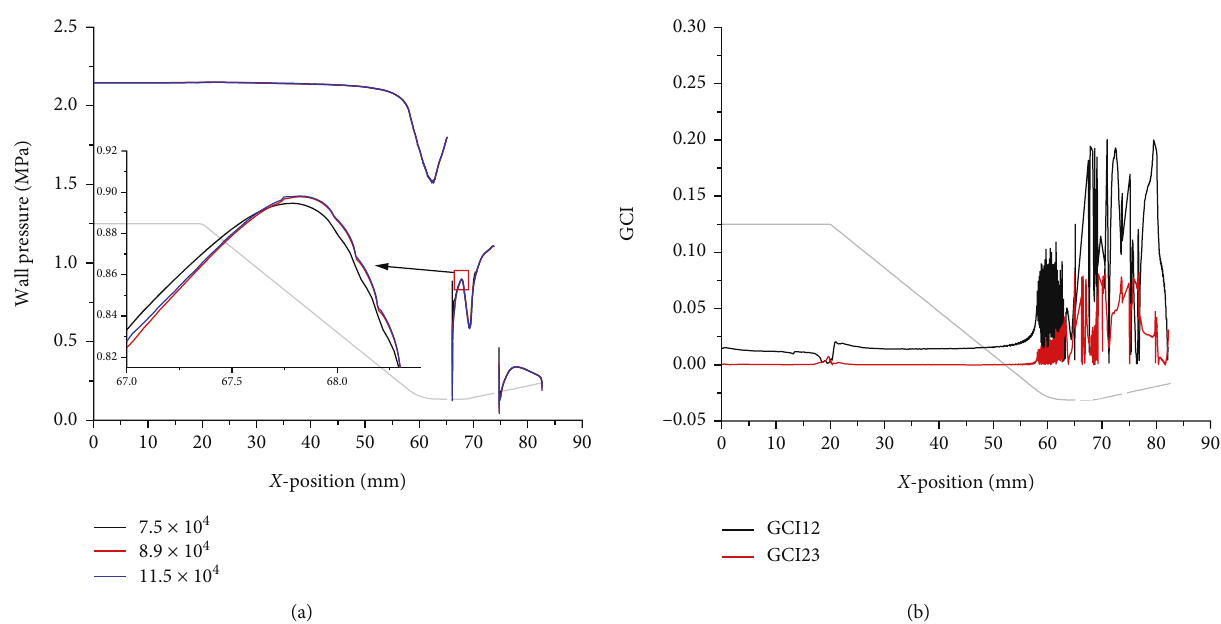
Figure 4: Grid independence veri fi cation: (a) wall pressure at di ff erent scales; (b) Grid Convergence Index between di ff erent